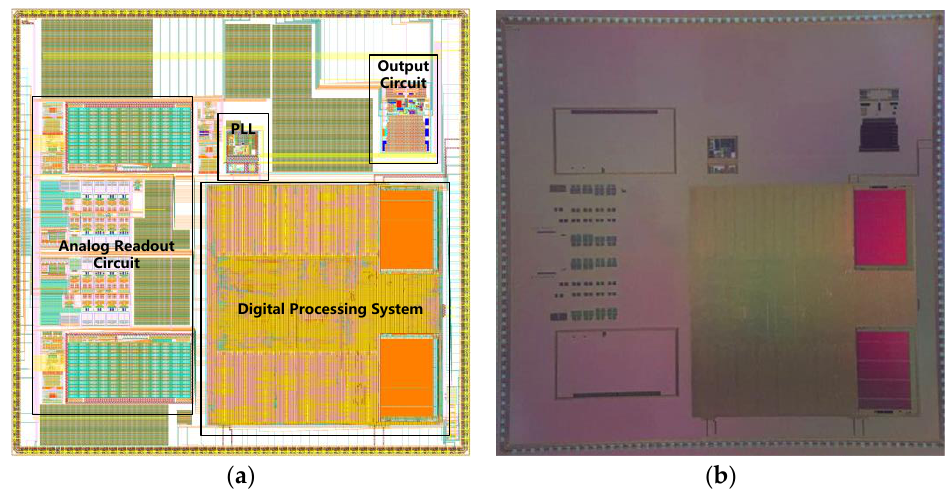
Figure 8. The layout and the die piecture of the designed SoC. ( a ) Chip layout; ( b ) die picture.